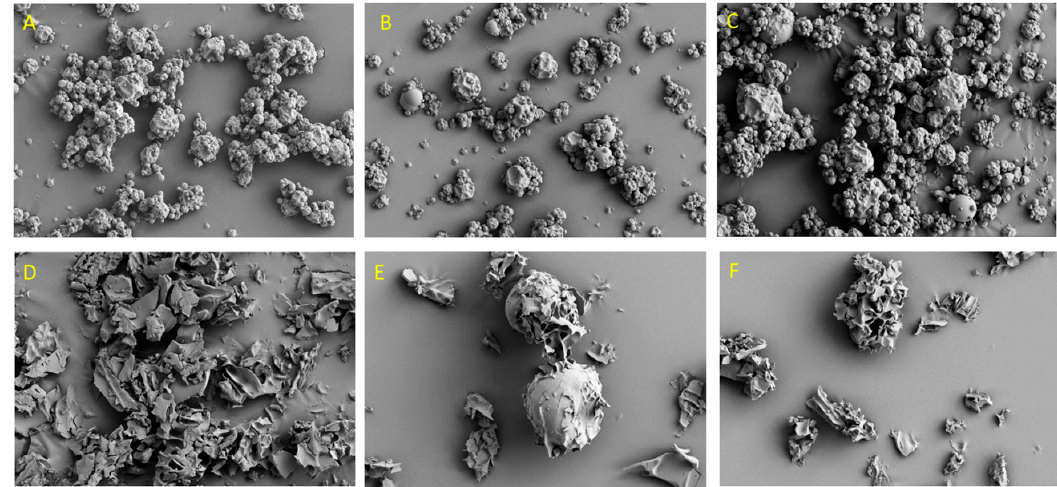
Figure 3. Scanning electron micrographs of the encapsulated lemon pomace aqueous extracts. ( A ) Spray-drying, maltodextrin; ( B ) spray-drying, maltodextrin + soybean protein; ( C ) spray-drying, maltodextrin + ι -carrageenan; ( D ) freeze-drying, maltodextrin; ( E ) freeze-drying, maltodextrin + soybean protein; ( F ) freeze-drying, maltodextrin + ι -carrageenan.